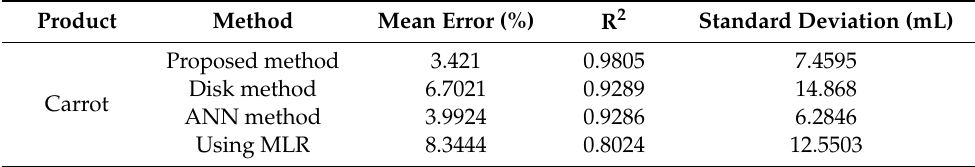
Table 7. Comparison between our proposed method and other methods on a carrot dataset.